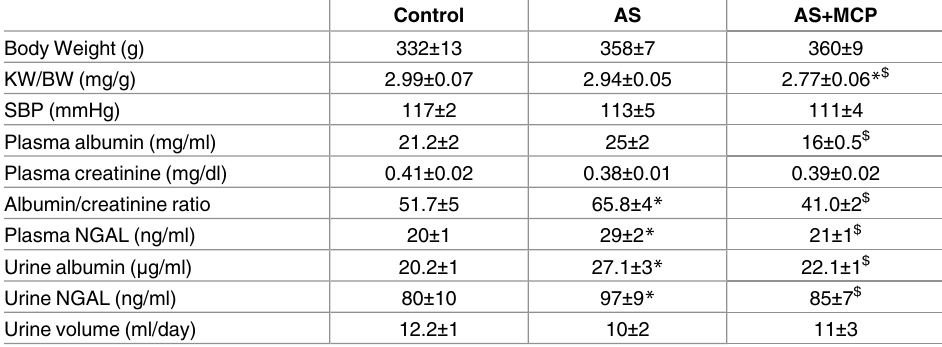
AS: aortic stenosis; MCP: modified citrus pectin; KW: kidney weight; BW: Body weight; SBP: systolic blood pressure; NGAL: neutrophil gelatinase-associated lipocalin. Data values represent mean ± SEM of 8